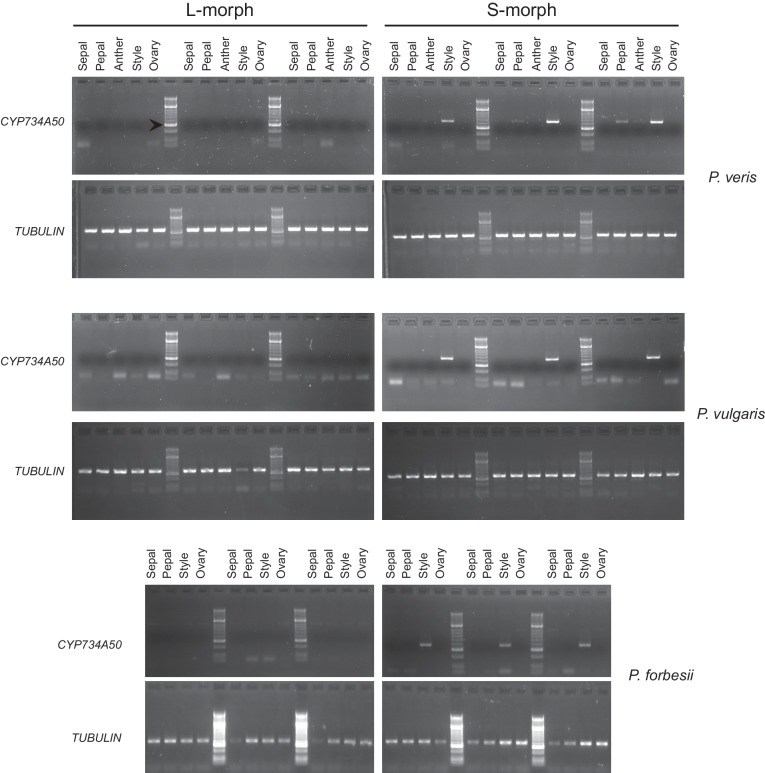
Style-specific expression of CYP734A50.Expression of CYP734A50 and TUBULIN in dissected floral organs of L- and S-morph plants of the indicated species as determined by RT-PCR. Three biological replicate sets of dissected flowers were analysed. Arrowhead marks 300 bp band in DNA-size standard.